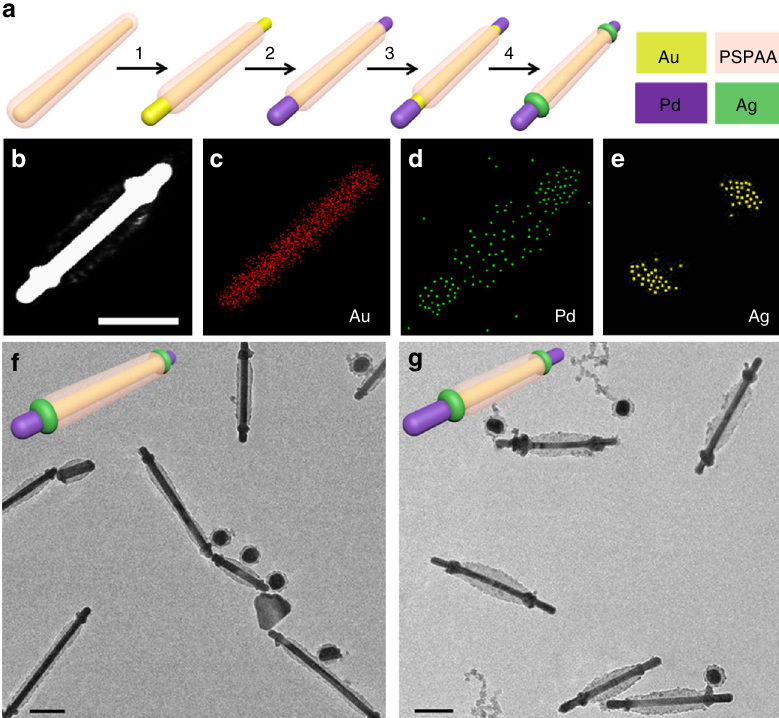
Fig. 5 Multi-step masked nanosynthesis. a Schematics illustrating the multi-step functionalization enabled by the continual contraction of the PSPAA shell. b – g STEM image, EDX mapping, and TEM image of the resulting Pd tip -Ag ring -(AuNR- 1 )@PSPAA-Ag ring -Pd tip , with short b – f and long g exposed segments. The scale bars are 100 nm